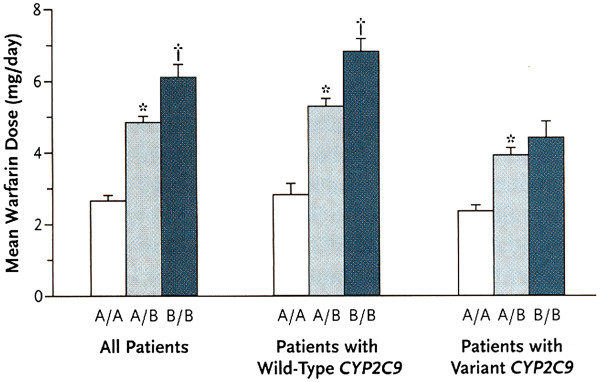
Effect of VKORC1 haplotypeA or B onwarfarin dosage. The asterisks denote p < 0.05 for the comparison with haplotype A/A, and the daggers denote p < 0.05 for the comparison with haplotype A/B. The T bars represent standard errors (adapted from
[15]).